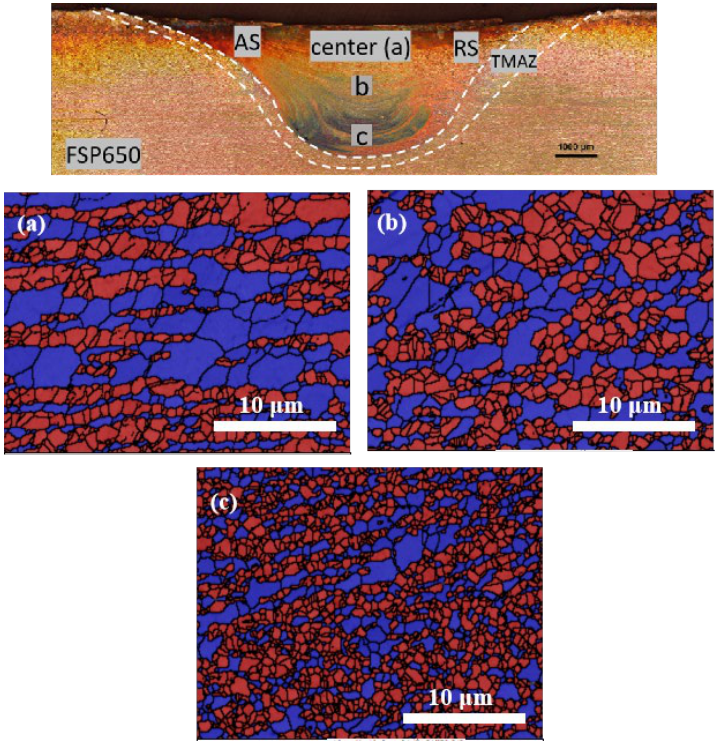
Figure 10. Phase maps of different regions ( a – c ) along the centerline of the FSPed SAF 2507 (ferrite and austenite are in blue and red, respectively).